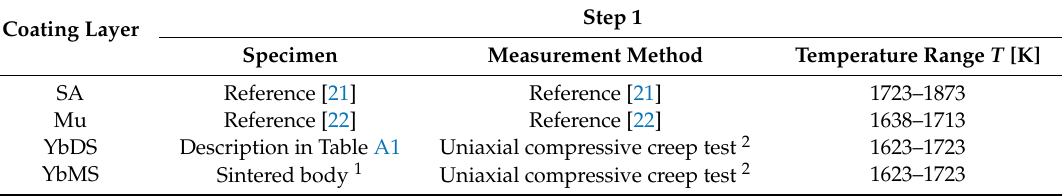
Table A4. Method of creep property estimation of the SiAlON, mullite, YbDS and YbMS layers (Step 1). Coating Layer